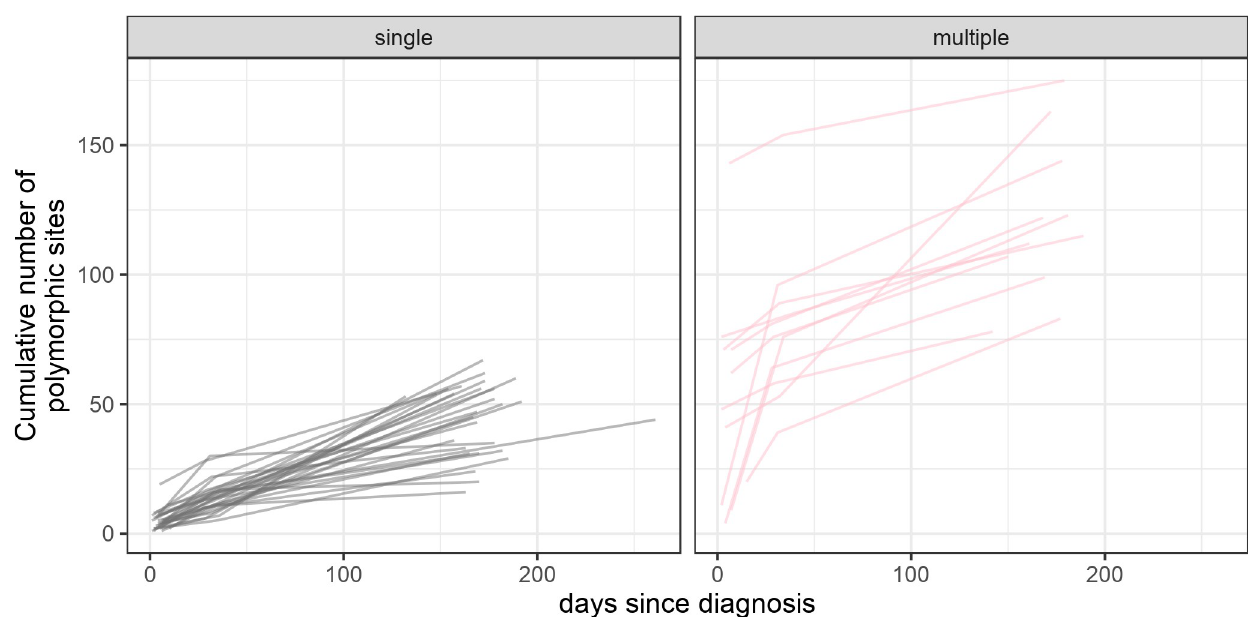
Fig 2. HIV-1 diversification kinetics over the first six months of infection for 39 RV217 participants. The cumulative number of polymorphic sites across all env sequences sampled for each participant are shown at three time points. Day 0 corresponds to the first HIV-1 positive RNA test. Participants with single founders are represented in grey, those with multiple founders in